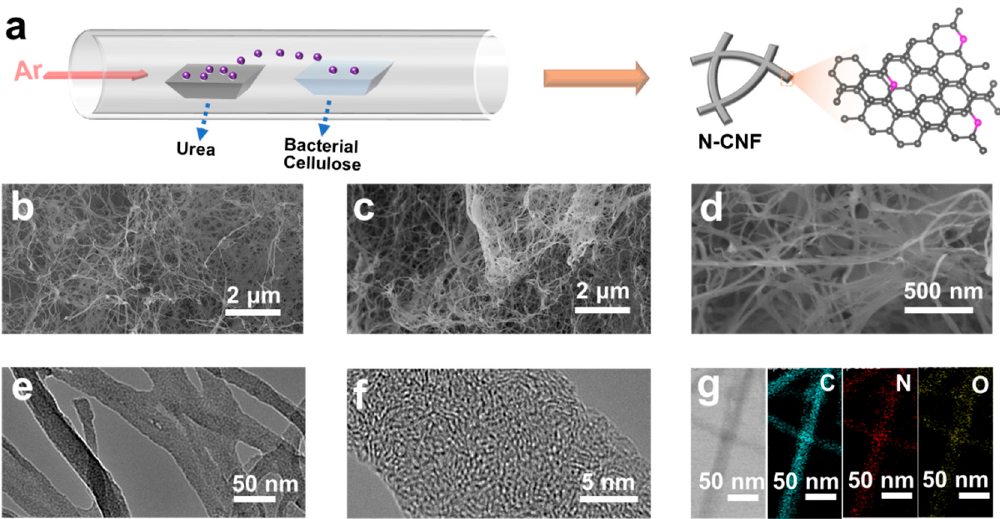
Figure 1. ( a ) Synthetic schematic process of N-CNF. SEM image of ( b ) CNF and ( c ) N-CNF, and ( d ) enlarged SEM image of N-CNF. ( e ) TEM image, ( f ) high-resolution TEM image and ( g ) element mapping of N-CNF.